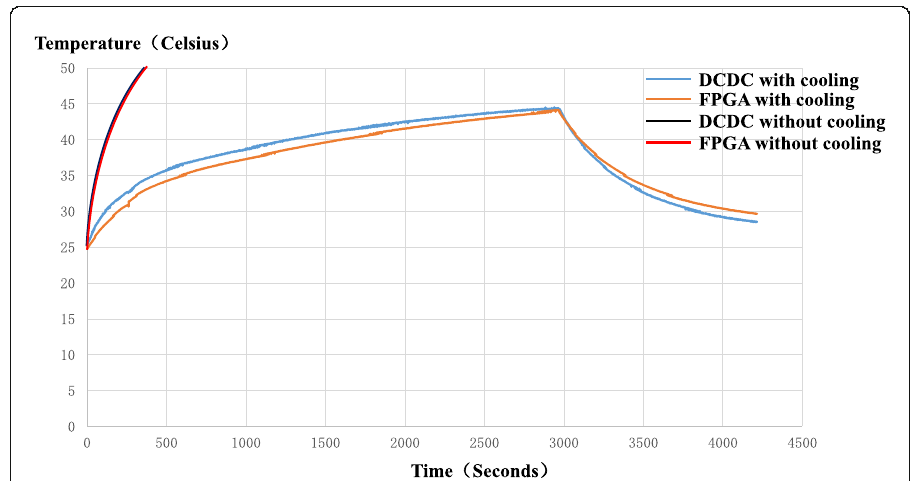
Fig. 8 The temperature variation curve of the FPGA board with or without phase-change cooling system in different positions